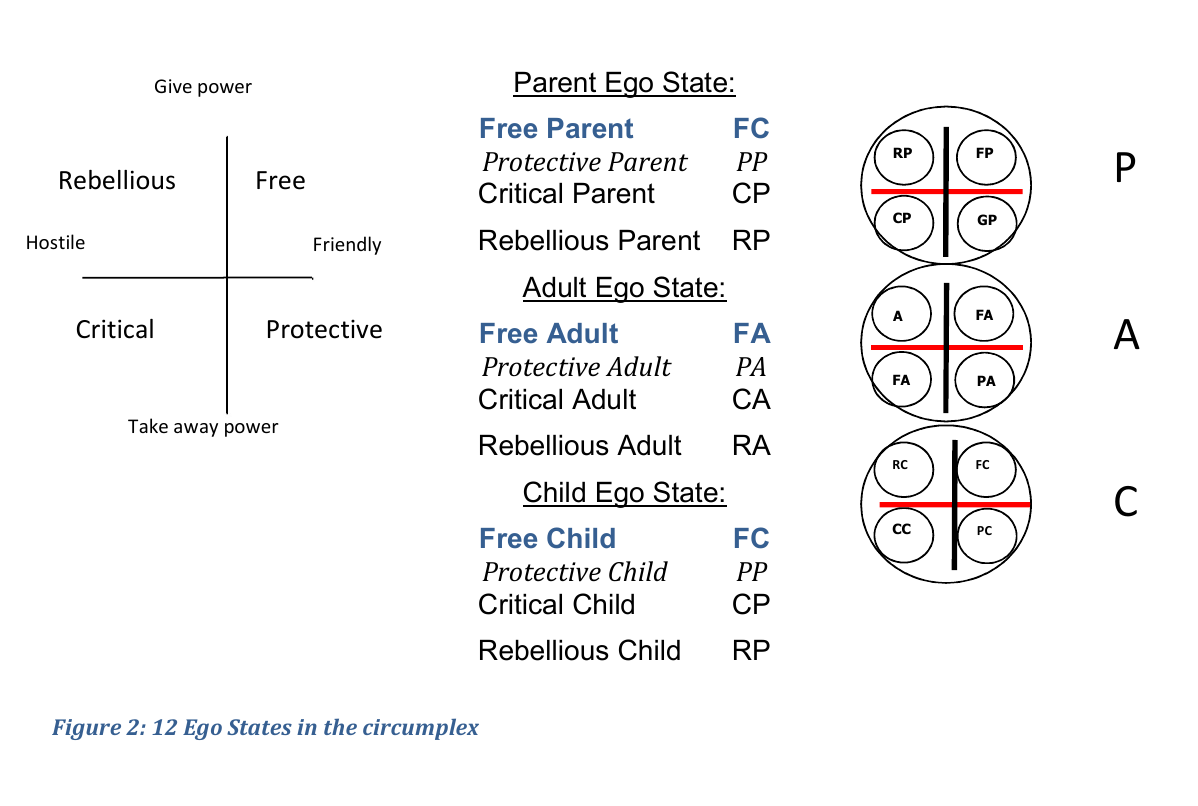
Figure 1: Ego States in Social-Cognitive TA